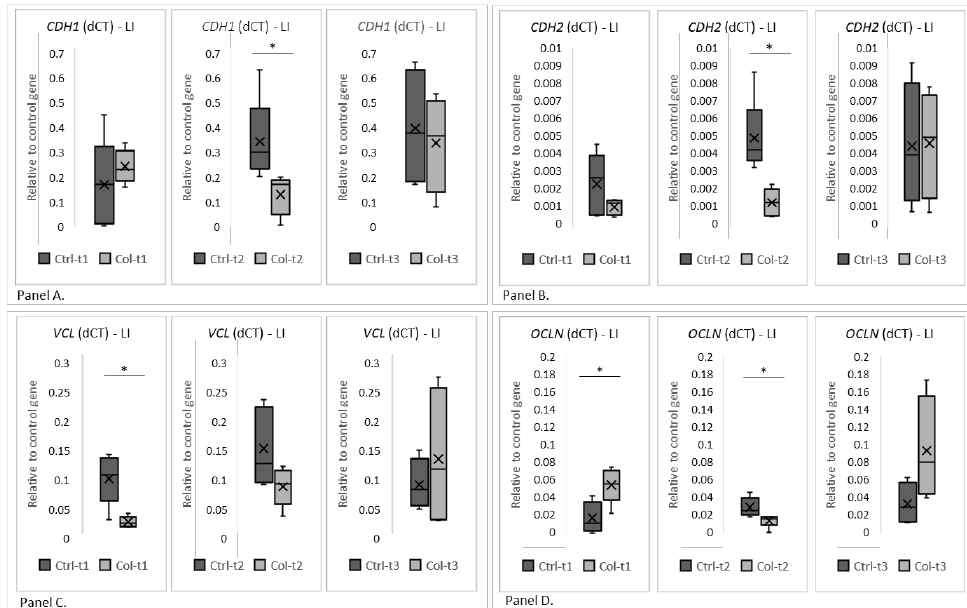
Figure 6. The charts show the dCt, the fold change of gene expression (relative to the housekeeping gene GAPDH) in the large intestine. ( Panel A ) shows CDH1 , ( Panel B ) shows CDH2 , ( Panel C ) VCL and ( Panel D ) OCLN . LI—large intestine. * p (two-tailed) ≤